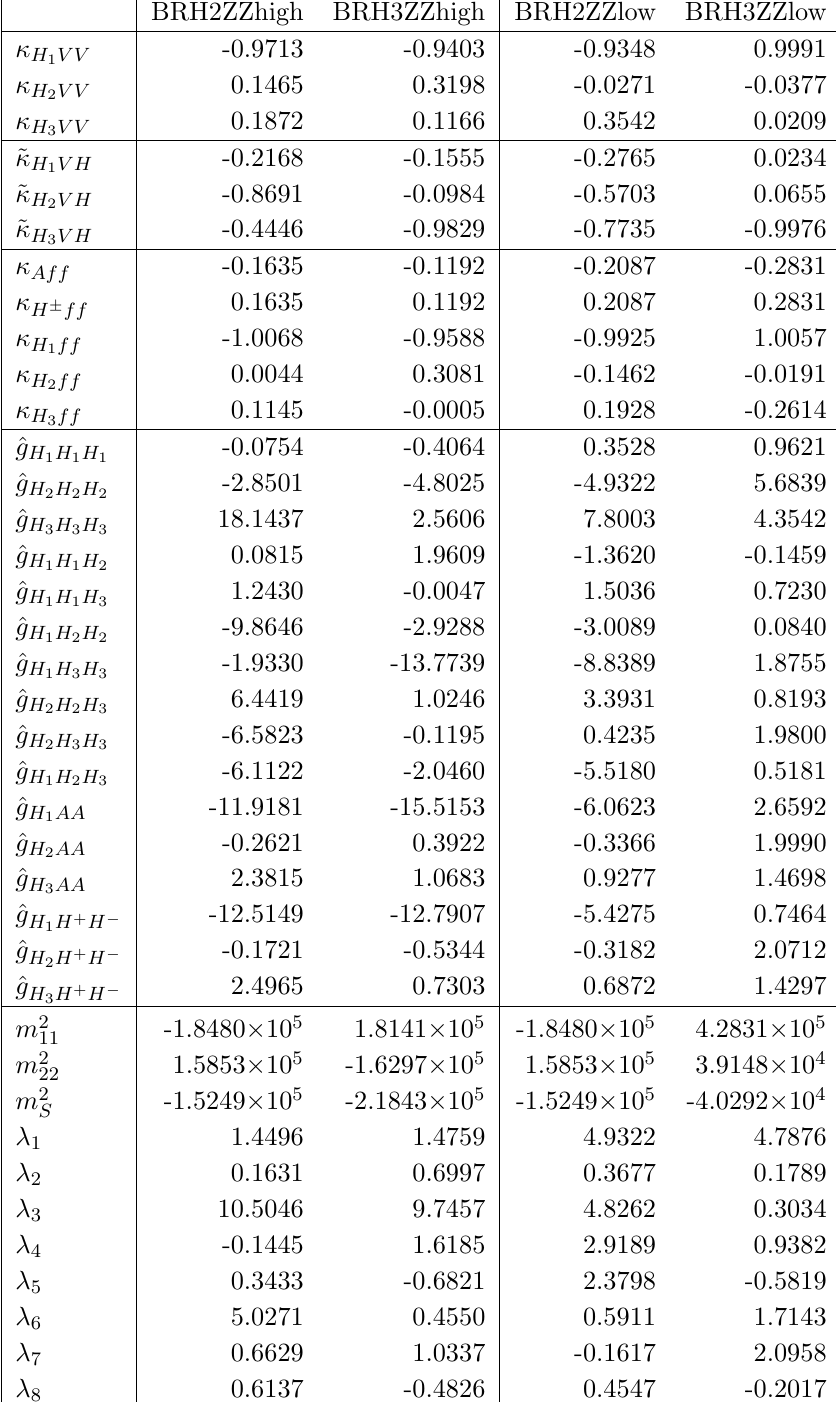
Table 12 . Higgs couplings to gauge bosons, fermions, and an illustrative subset of trilinear self-interactions, for the di(cid:11)erent benchmark scenarios used in the analysis of the decay modes H 2 ; 3 ! ZZ in section 7. The lowest rows display the values of the mass terms squared (in GeV 2 ) and quartic couplings in the Higgs potential eq. (2.3). The corresponding input parameters are given in table